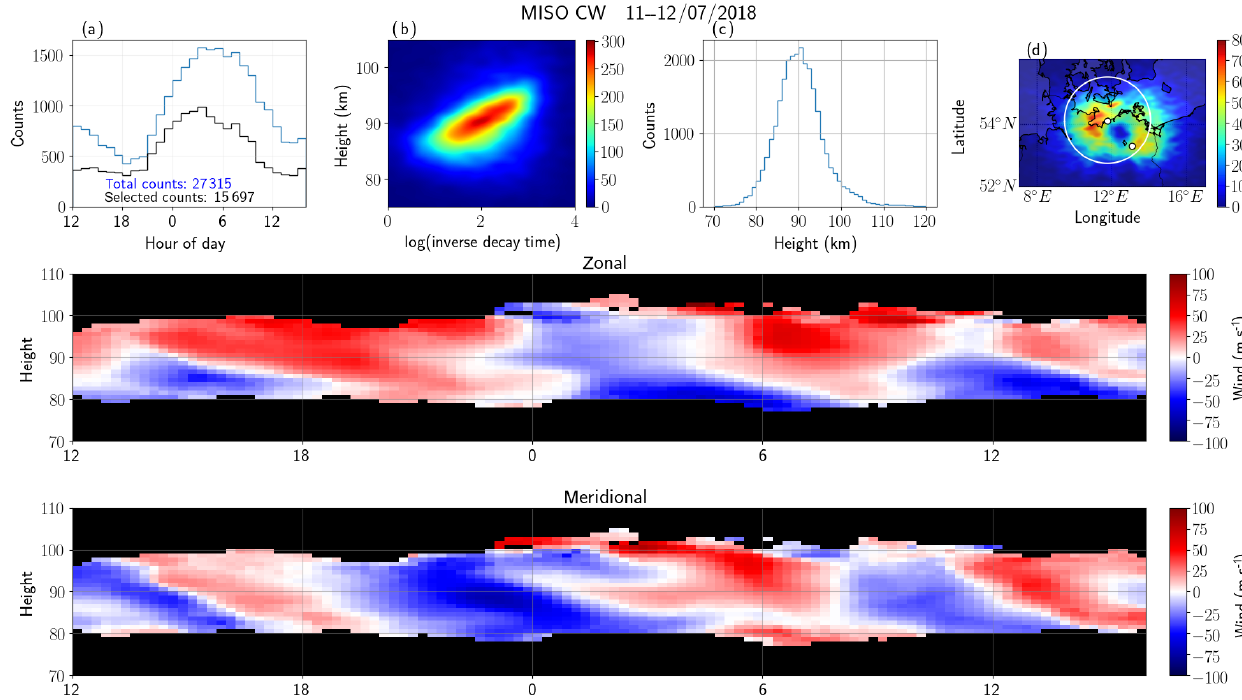
Figure 4. Similar to Fig. 2 but for the MISO-CW system, i.e., the signals of five synthetic receivers have been incoherently integrated. The transmitter and receiver sites are indicated with small white circles in (d) . Note that the region of fewer counts in (d) is over the midpoint of the receiver and transmitter